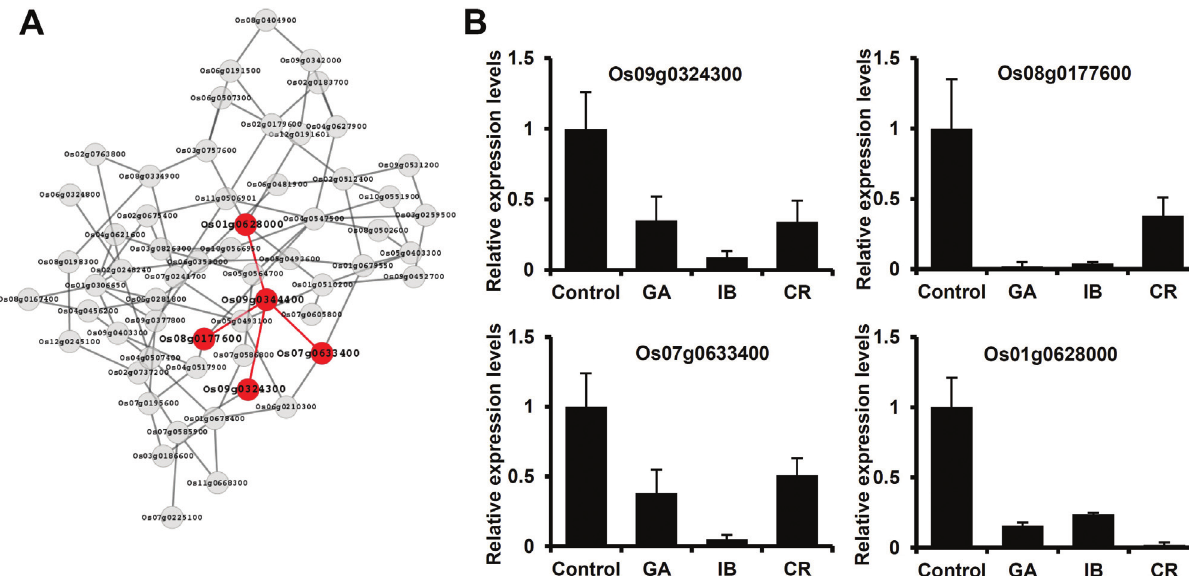
Figure 6 - Co-expression relationships between OsFBX322 and related genes. (A) OsFBX322 (Os09g0344400) functional gene interactions within a co-expressionnetworkconstructedbyRpackageARACNE.Nodesandedgesrepresentthedifferentgenesandtheirfunctionalinteractions,respectively. Genes and interactions highlighted in red closely interacted with OsFBX322 (Os09g0344400). (B) qRT-PCR analysis of co-expressed genes in rice after exposure to GA, IB, or CR. Control, non-irradiated; GA, 200 Gy gamma-irradiation; IB, 40 Gy carbon ions; CR, exposure on an unmanned spacecraft for 15